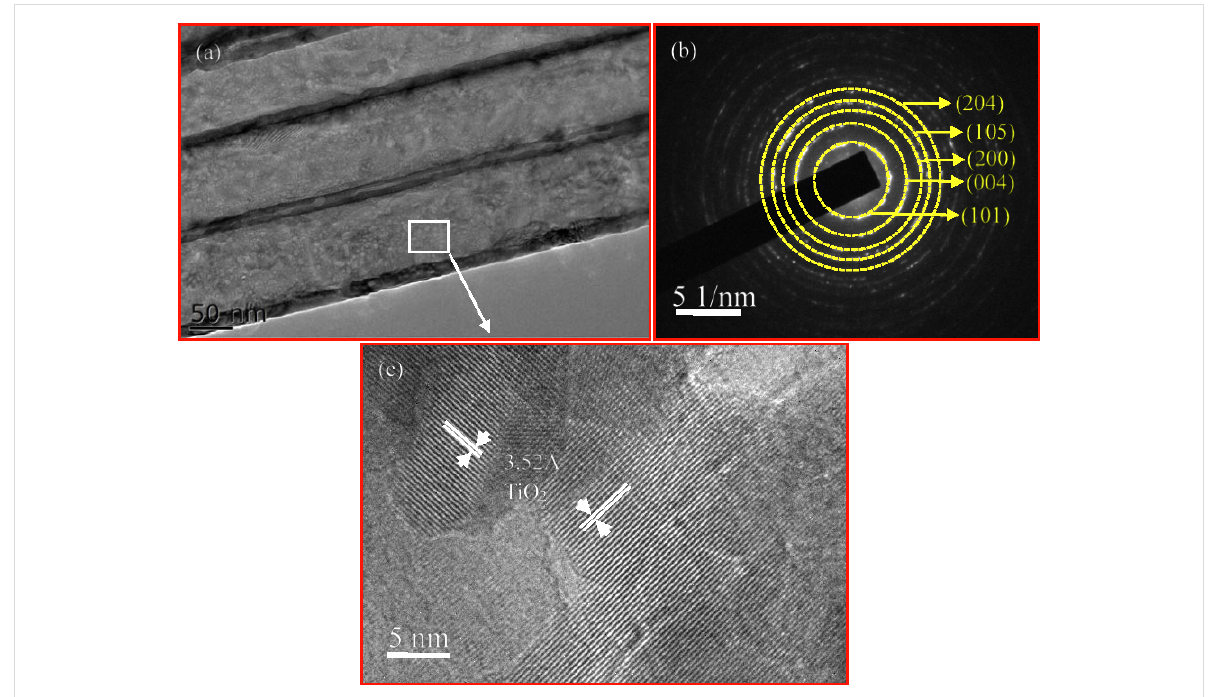
Figure 3: TEM images of the pure TiO 2 nanotubes heat-treated at 500 °C for 2 h; (a) TEM image of the pure TiO 2 nanotubes, (b) SAED pattern showing the presence of TiO 2 nanocrystals, and (c) HRTEM image of a pure TiO 2 nanotube.